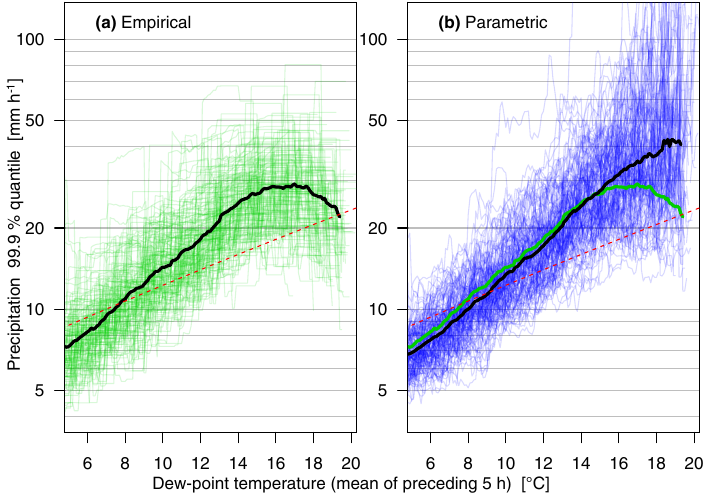
Figure 3. The 99.9% precipitation intensity per temperature bin with empirical and parametric quantile estimate ( a and b respectively). Each line represents one of the 142 stations, with the black line as the average across stations. The red line denotes CC scaling as in Fig. 1. The green line in (b) repeats the average from (a) for comparison.